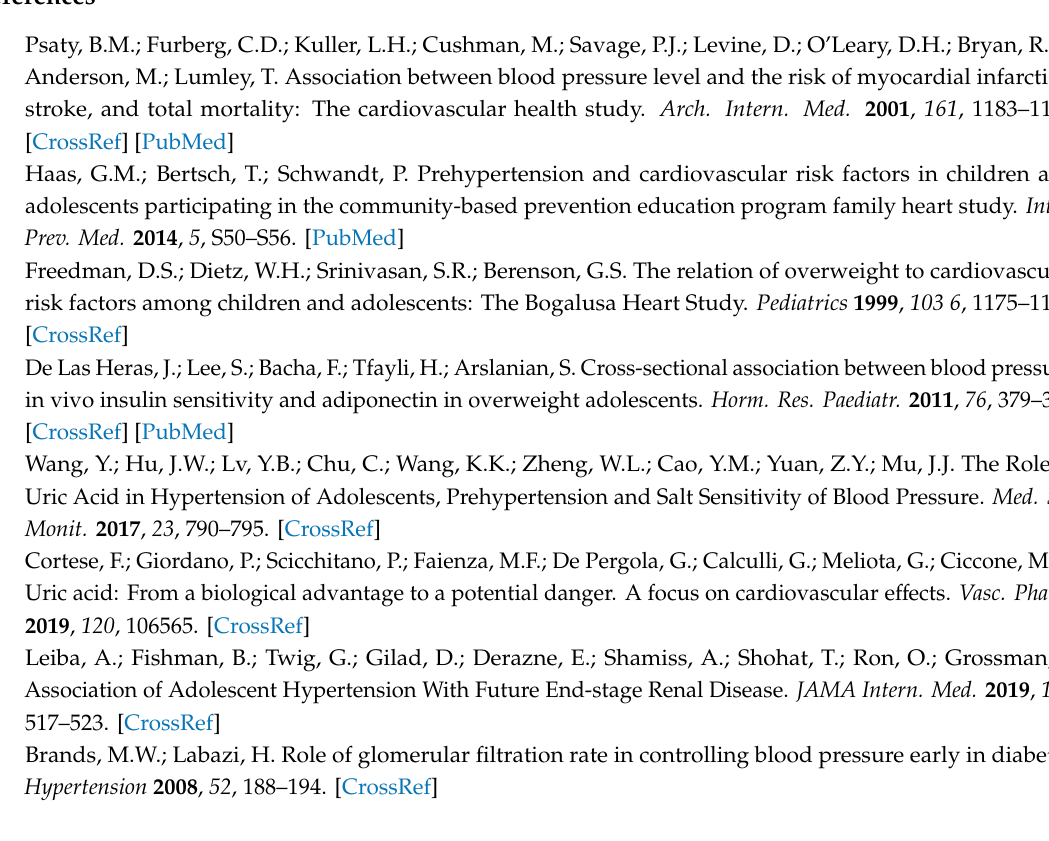
Table S1: Characteristics of females presenting cardiometabolic abnormalities. Table S2: Characteristics of females not presenting cardiometabolic